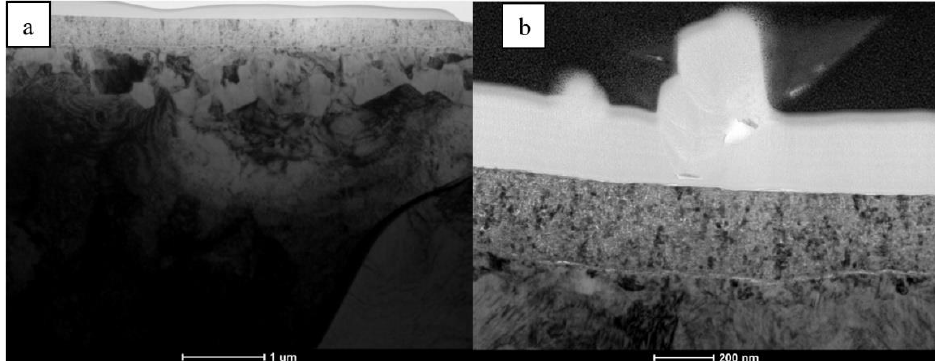
Figure 2. TEM/BF images of cross-section microstructure of TiN layer formed on PN and carbon coated Ti-6Al-7Nb alloy showing: ( a ) overview of smooth surface and ( b ) fragments of nano-whiskers.